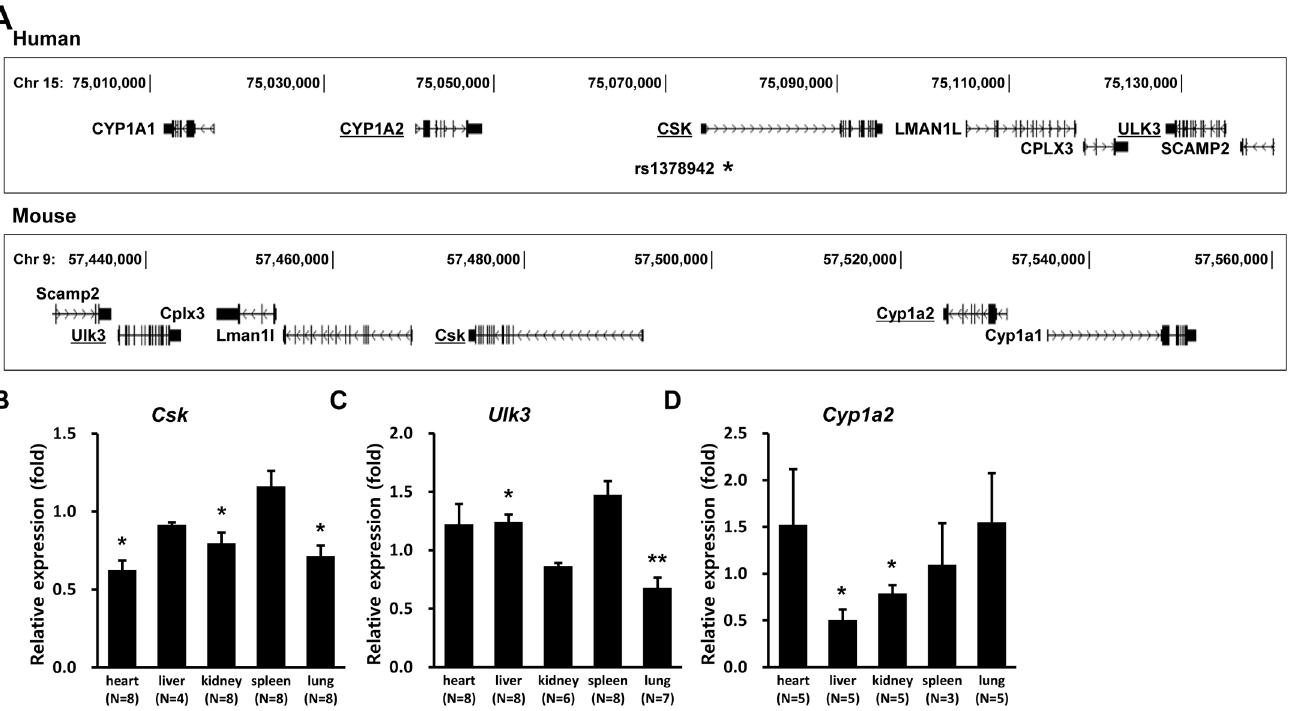
Fig 1. Location of candidate genes in the 15q24 GWAS locus and reduction of target gene mRNAs in siRNA-injected mice. (A) Positions of candidate genes are comparably shown on the human 15q24 locus and on the homologous mouse chromosome 9, 31.18 cM in the opposite direction; * indicates position of rs1378942, the lead SNP for blood pressure GWASs in the 15q24 locus. (B) The relative expression of candidate gene mRNAs in each tissue is presented as the fold change of relative mRNA levels in candidate gene versus control siRNA-injected mice after 1-time siRNA injection. Error bars show the mean ± SEM. Number in parentheses indicates the pair number of mice used for real-time PCR analysis. P values were calculated by Mann-Whitney U-test. * P < 0.05 versus respective controls.